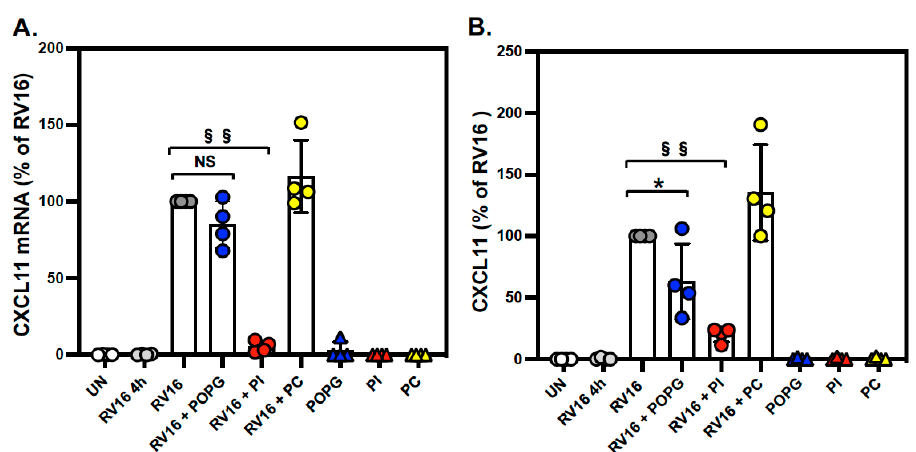
Figure 3. PI reduced CXCL11 mRNA expression and protein secretion in RV-A16-infected AECs. Differentiated human AECs were treated with POPG, PI, or POPC, added to apical media, for 16 h prior to virus infection at an m.o.i. of 0.02 pfu/cell for 4 h at 35 °C, either with or without lipid treatments. Following DPBS wash to remove unbound virus at 4 h, the cells were cultured for 48 h, either with or without lipids. Groups consisted of uninfected ( UN: white circle), viral binding and cell entry at 4 h ( RV16 4 h: gray circle), the virus alone at 48 h p.i. ( RV16: dark gray circle), the virus + POPG (10 mg/mL) ( RV16 + POPG: bule circle), the virus + PI (4 mg/mL) ( RV16 + PI: yellow circle), the virus + POPC (20 mg/mL) ( RV16 + PC ), and lipids alone ( POPG , PI , and PC ). ( A ) CXCL11 mRNA expression and ( B ) CXCL-11 protein secretion induced by RV-A16 with or without lipid treatment. The lipid treatment alone were shown as POPG (blue triangle), PI (red triangle) and PC (yellow triangle). The data are from 4 different donors and are shown as mean ± SD from 3 independent experiments for each individual. * Indicates p < 0.05, §§ indicates p < 0.001, respectively. NS indicate not significant.